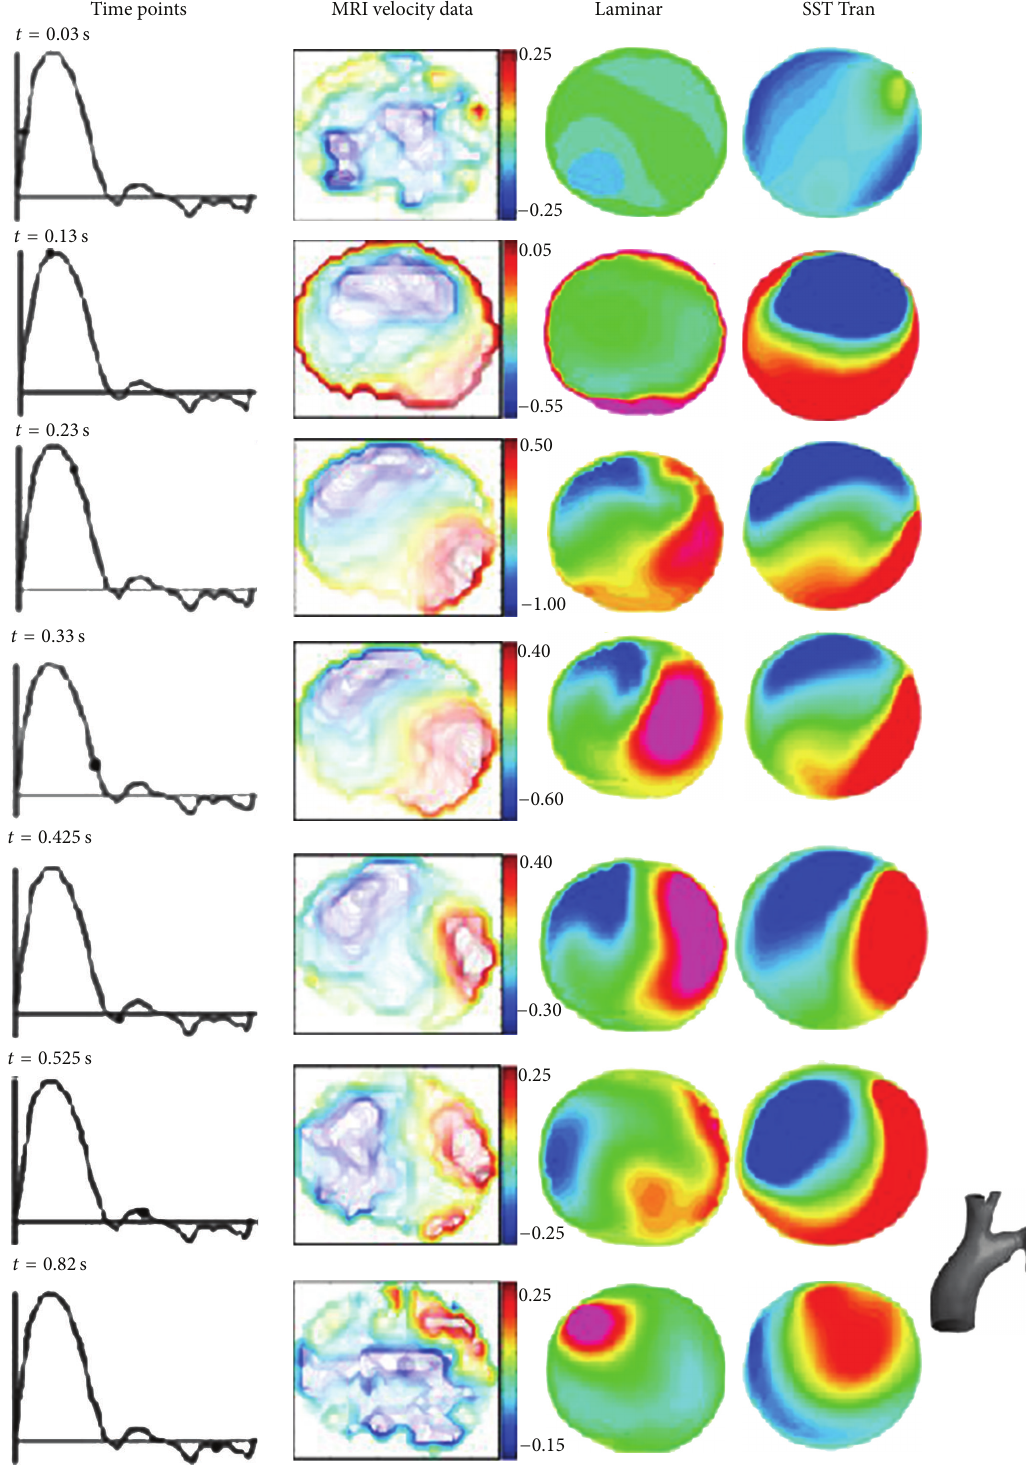
Figure 1: Comparison of axial velocity profiles at different time points along the cardiac cycle between MR velocity data (in m/s) and simulation results using (i) laminar flow model and (ii) SST transitional flow model (SST Tran)